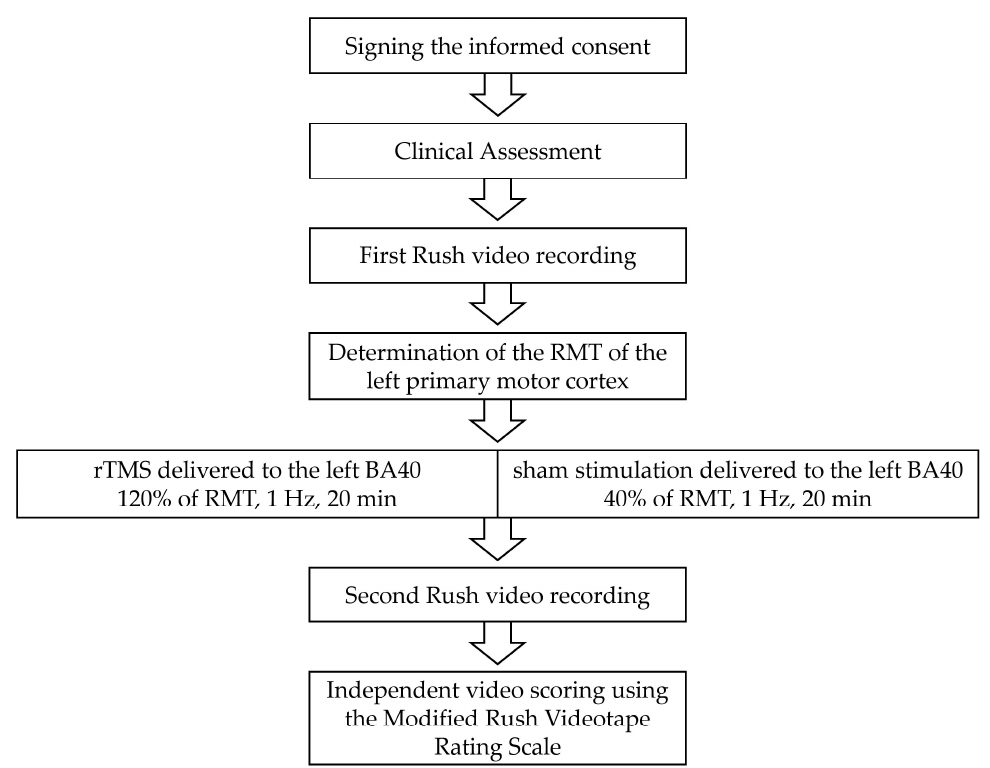
Figure 1. Flow diagram of the study procedure. After obtaining written informed consent, a clinical assessment was conducted. Subsequently, the first Rush video protocol was recorded to capture tic symptoms. Next, following resting motor threshold (RMT) determination, rTMS or sham stimulation was applied. This was followed by the second Rush video protocol recording. Finally, two independent raters scored the videos using the Modified Rush Videotape Rating